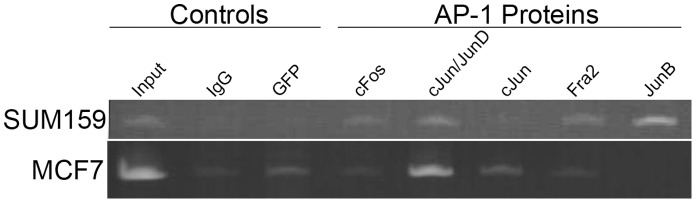
Differential AP-1 factor binding to CR1 in breast cancer cells.ChIP with AP-1 antibodies resulted in amplification of a region of CR1 with inverted repeat AP-1 binding sites. Rabbit IgG and anti-GFP antibody served as negative control. Representative results of at least two independent immunoprecipitation experiments and multiple independent PCR analyses are shown. Strong PCR amplification of CR1 region with JUNB binding was seen in SUM159 cells and with JUND binding in MCF7 cells.